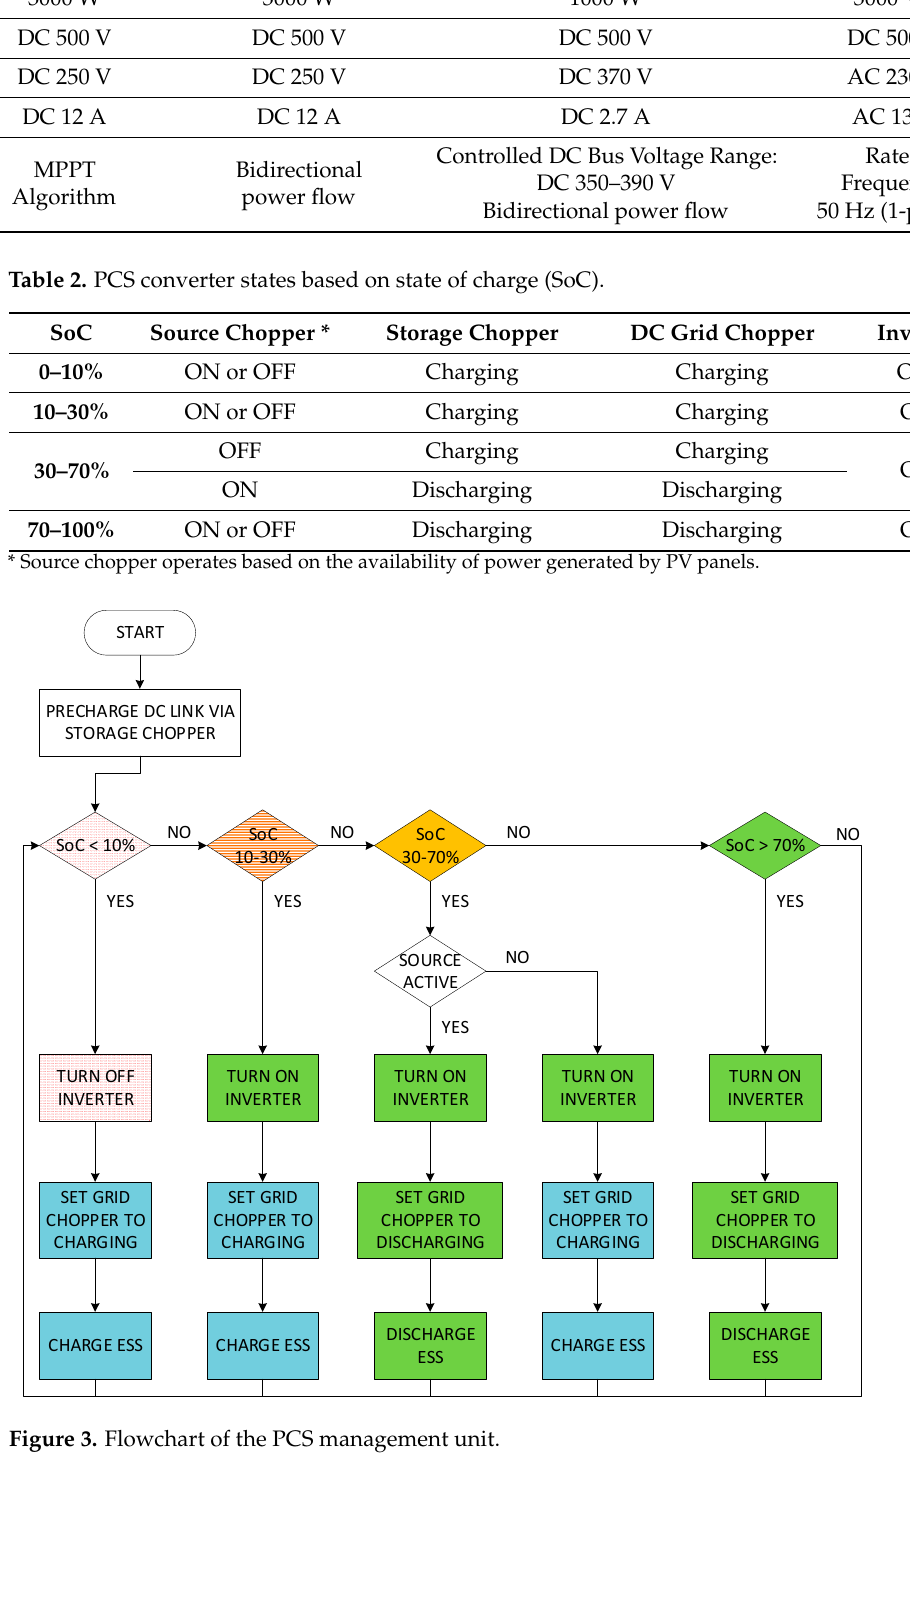
Table 1. Specifications of each converter in a PCS unit.